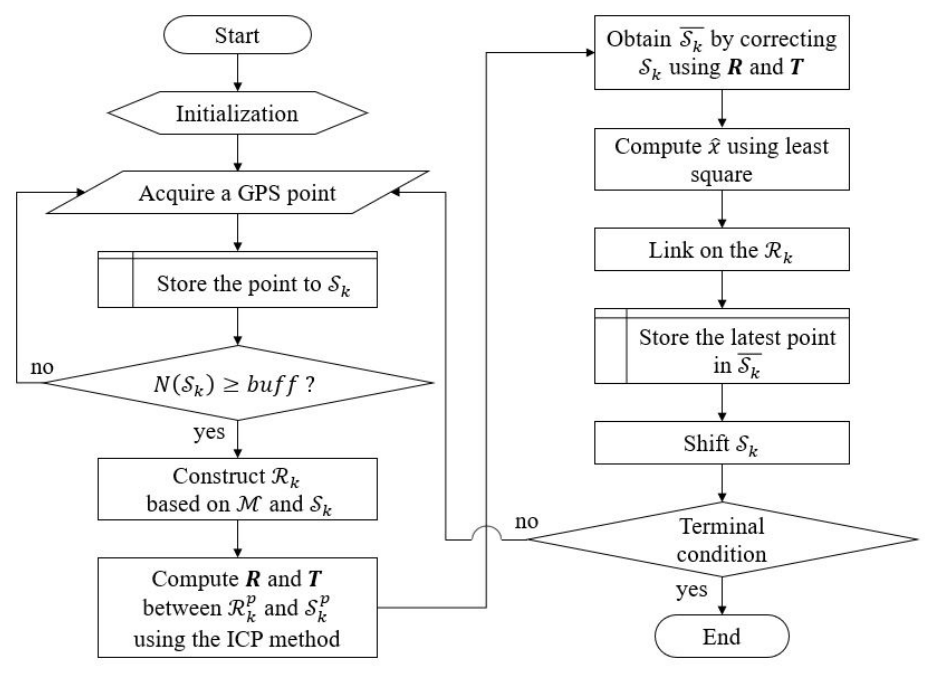
Figure 3. Flowchart of the proposed